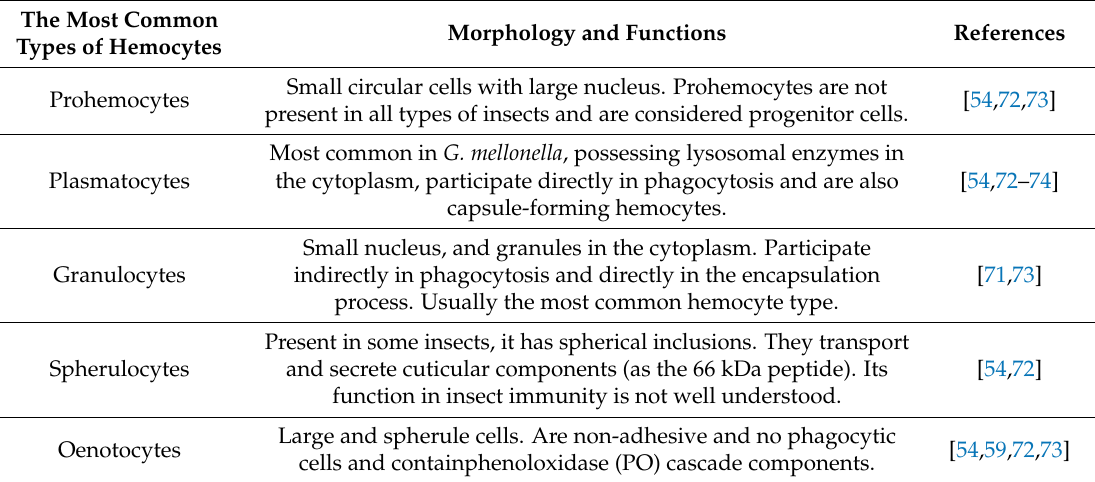
Table 1. Different types of hemocytes present in hemolymph of larva of Galleria mellonella and their main